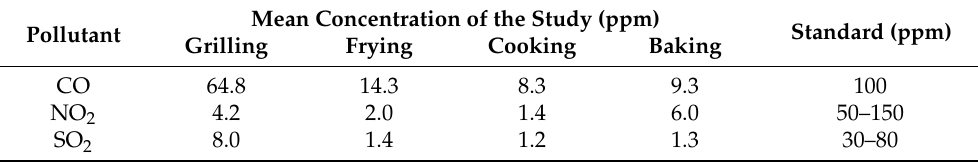
Table 4. Mean levels of pollutants in chimneys compared to emission standards.